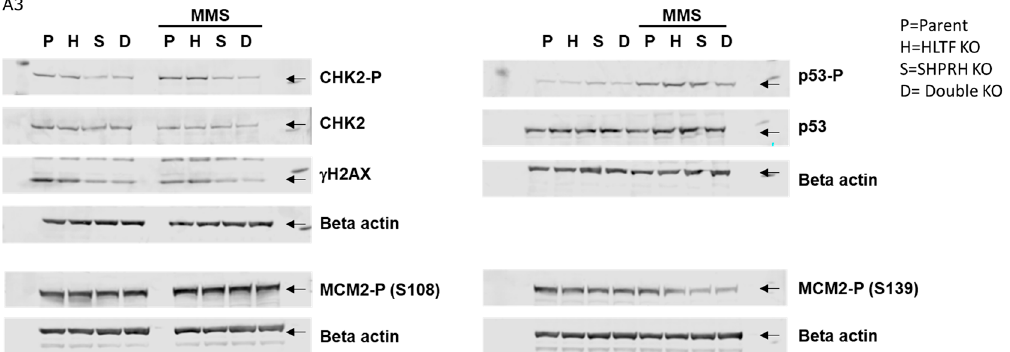
day 0). Related to Figure 1 .